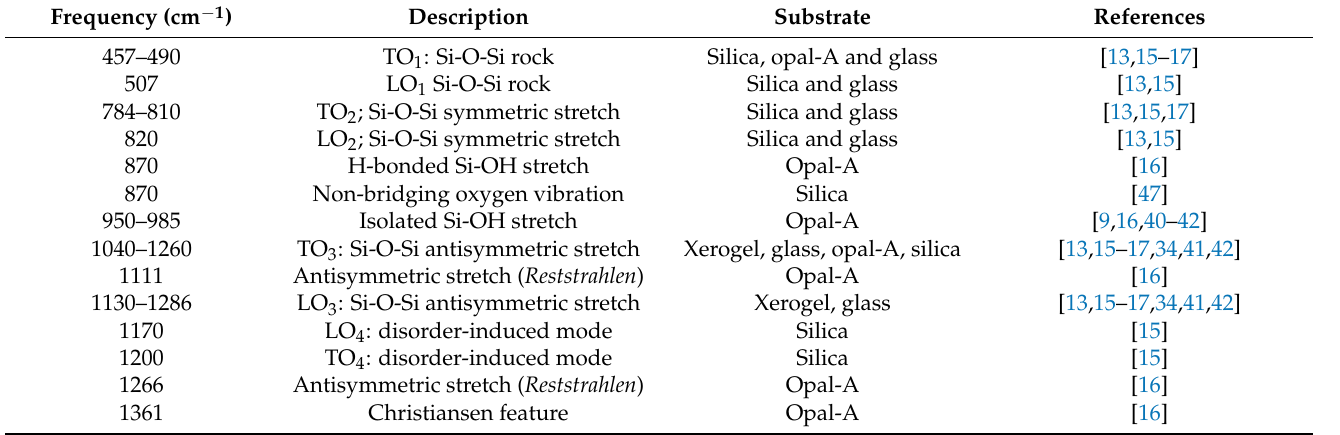
Table 2. Literature review of assigned IR features seen for silica species, grouped by band (see